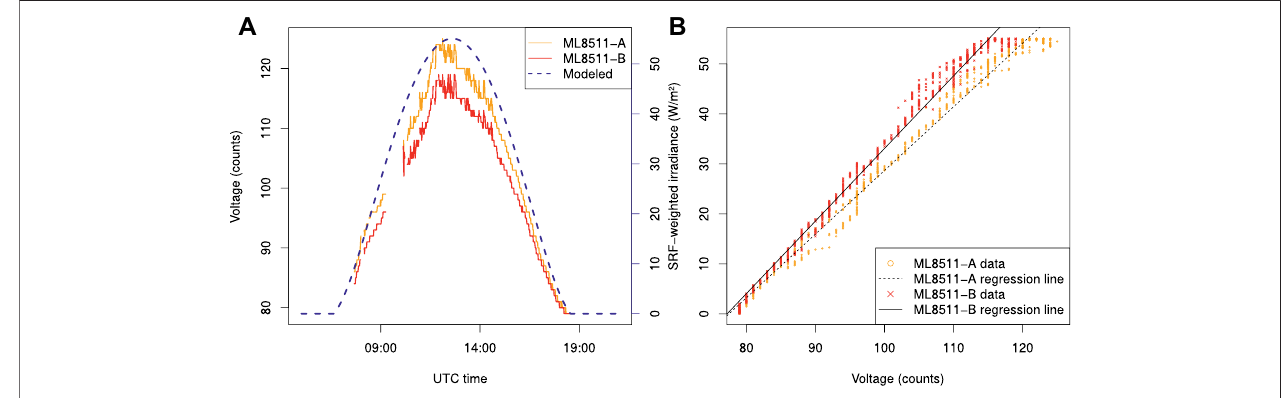
FIGURE 7 | Comparison of model estimations and ML8511 measurements: diurnal evolution (A) and regression (B) .